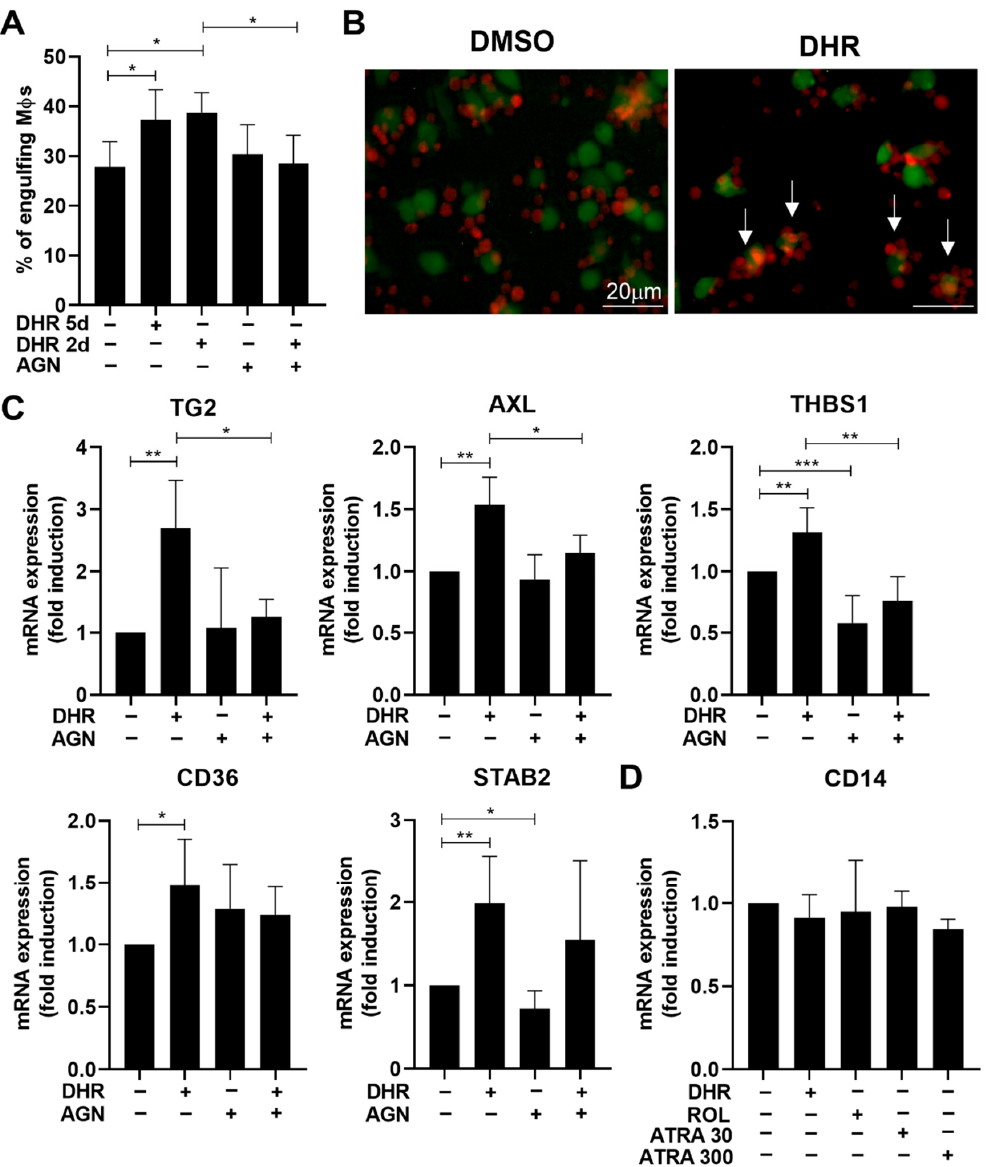
Figure 1. Dihydroretinol administered during monocyte differentiation enhances efferocytosis of macrophages by upregulating the expression of several efferocytosis-related molecules in an RAR- dependent manner. ( A ) Percentage of engulfing macrophages differentiated in the absence or presence of 1 μ M DHR administered either during the whole 5 days or only the last 2 days of their differentiation in the presence or absence of 0.5 μ M AGN194310, a highly selective pan-RAR antagonist. ( B ) Representative fluorescent microscopic images of macrophages (green) engulfing apoptotic thymocytes (red) after being kept in the presence and absence of 1 μ M DHR during the last 2 days of differentiation. Non-engulfed apoptotic cells appear as red, while the engulfed appear as orange colors, as a result of the overlapping green and red colors of the two types of cells. Arrows point to macrophages covered by tethering apoptotic thymocytes. ( C ) mRNA expression of several efferocytosis-related genes in macrophages exposed to 1 μ M DHR during the last 2 days of their differentiation in the presence or absence of 0.5 μ M AGN194310 determined by qRT-PCR. β -actin was used as a reference gene. ( D ) Lack of induction of CD14 mRNA expression by 1 μ M DHR, 1 μ M ROL, and by 30 or 300 nM ATRA. All data are expressed as mean ± SD ( n = 3 in A , and n = 4 in C )). Asterisks indicate statistically significant difference (* p < 0.05, ** p < 0.01, and *** p < 0.001). Each culture contained 0.5% v / v